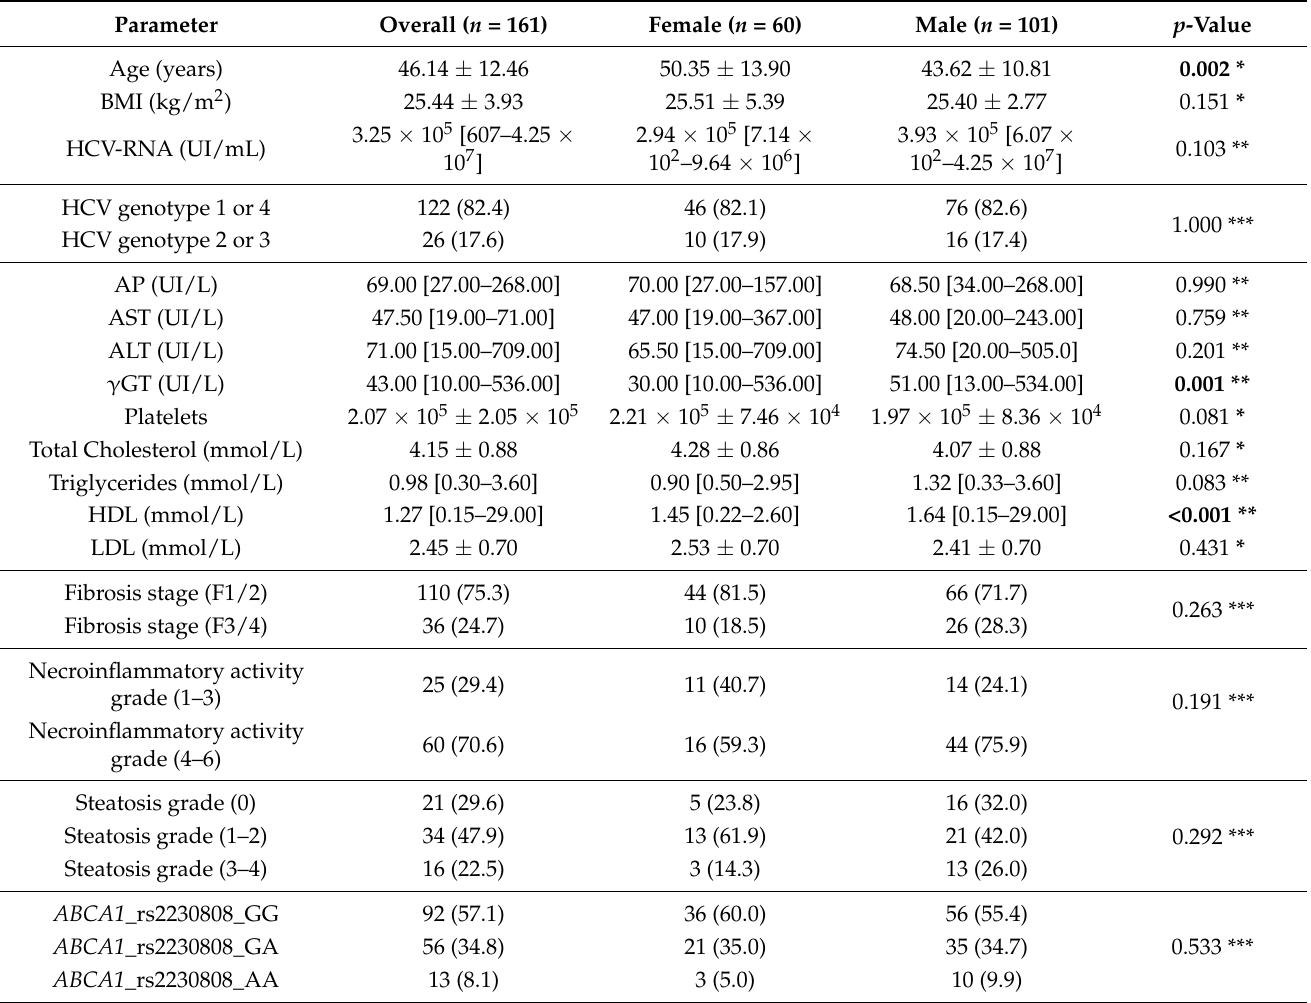
Table 1. Baseline clinical, biochemical, histological, and genetic parameters of